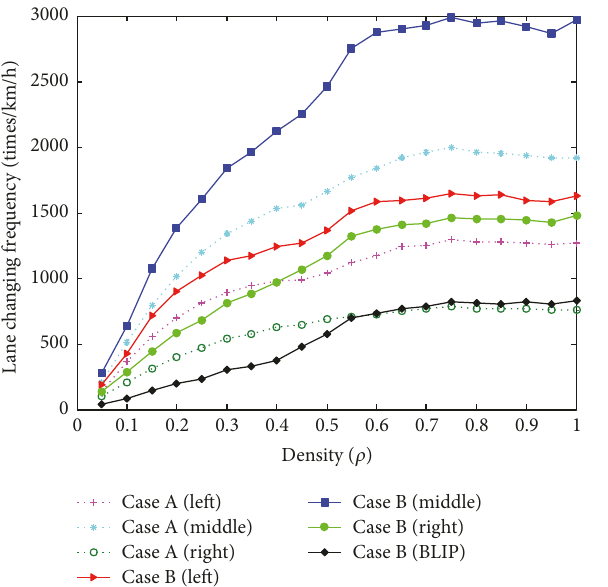
Figure 12: Lane usage of Case A and Case